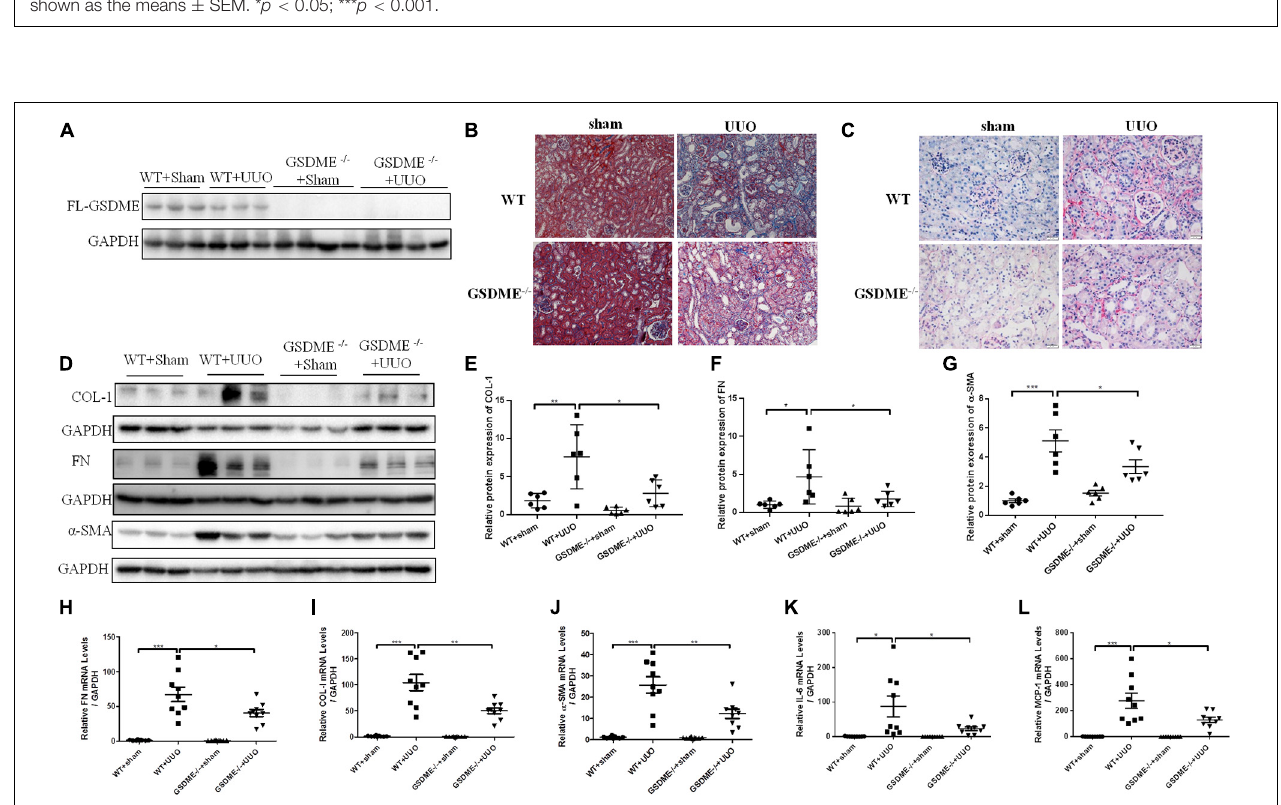
FIGURE 2 | Gasdermin E deletion ameliorates UUO-induced renal fibrosis and inflammation. GSDME knockout (KO) mice and wild-type (WT) mice were used to define the role of GSDME in UUO-injured kidneys. (A) Western blotting analysis of GSDME protein expression in GSDME KO kidneys and the controls ( n = 3–4). (B) Masson staining of kidney sections of GSDME KO mice and WT mice (200 × ). (C) Sirius Red staining of GSDME KO mice and WT mice (400 × ). (D–G) Western blotting analysis of fibronectin (FN), Collagen-1 (COL-1) and alpha-smooth muscle actin ( α -SMA) in mouse kidneys from different groups ( n = 6). (H–L) qPCR analysis of FN, COL-1, α -SMA, IL-6 and MCP-1 in mouse kidneys from different groups ( n = 9). The quantitative results were shown as the means ± SEM. * p < 0.05; ** p < 0.01; *** p < 0.001.